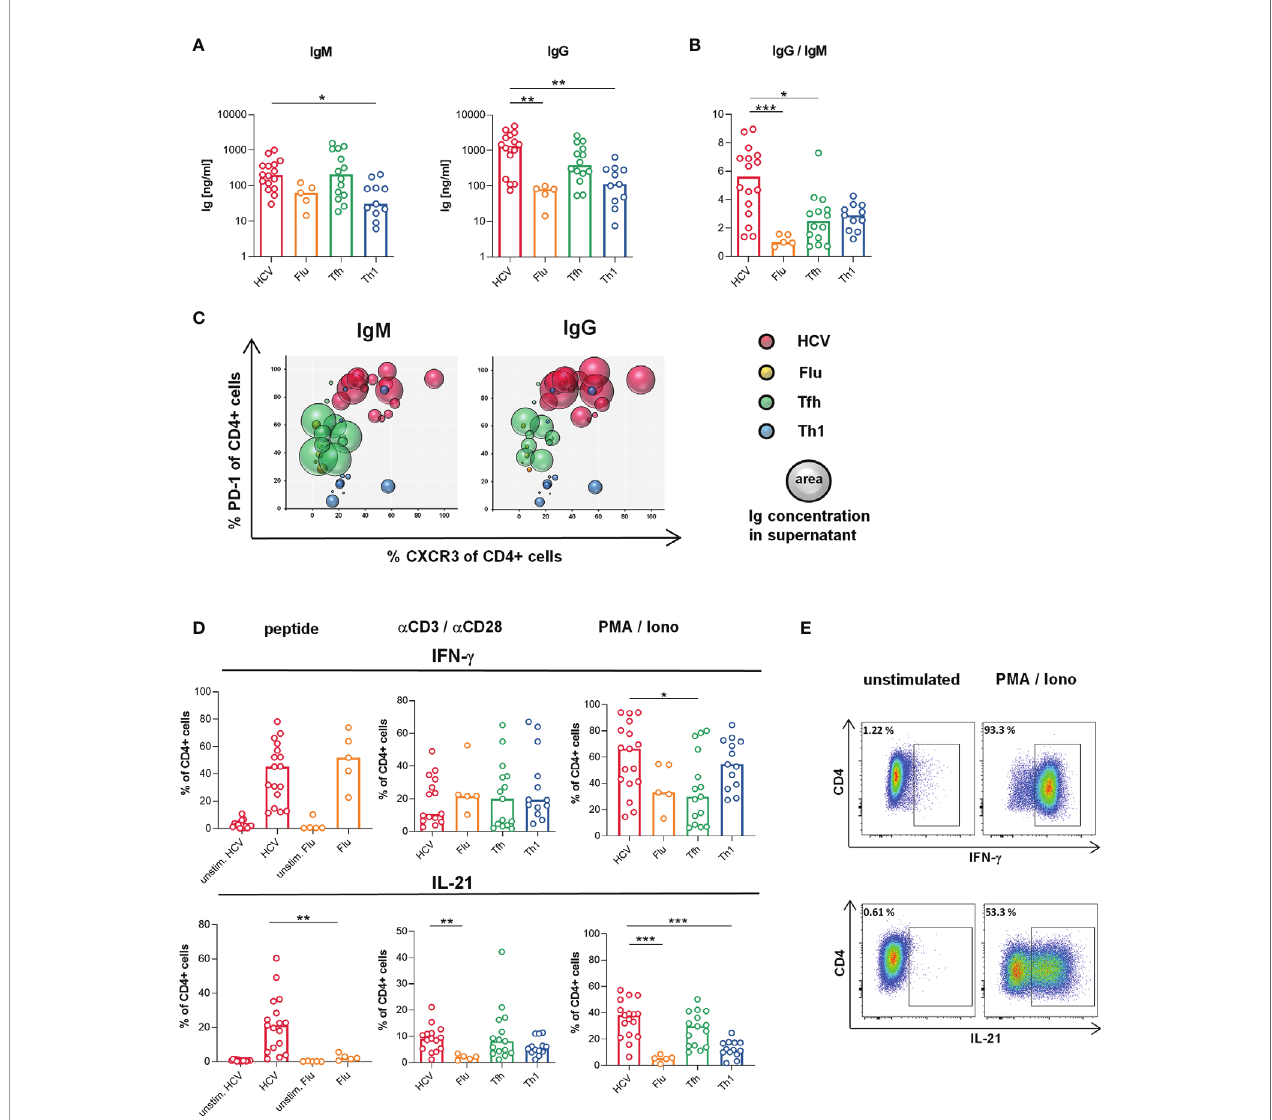
FIGURE 2 | Superior B cell helper capacity despite Th1-biased cytokine production of HCV clones. (A, B) B cell helper capacity was analyzed by coculture of the CD4 T cell clones (n = 16 HCV, 5 Flu, 14 Tfh, 11 Th1 clones) with naive allogeneic B cells for 7 d (A) Concentrations of IgM and IgG in cell-free coculture supernatants were determined by ELISA. (B) Class switch induced by the CD4 T cell clone types as ratio of IgG and IgM concentration in culture supernatants. For coculture system validation plasmablast formation was correlated with produced Ig (Supplementary Figure 7A) . B cell positive and negative controls and autologous in-run controls are shown in Supplementary Figures 7C, D , respectively. (C) The correlation of CXCR3 and PD-1 surface expression (shown in Figures 1D ) with the individual B cell helper capacity is visualized in bubble plots (n = 16 HCV, 5 Flu, 11 Tfh, 11 Th1 clones). (D) Production of IFN- g and IL-21 by the CD4 T cell clone types was determined by fl ow cytometry after stimulation with their respective peptide (n = 17 HCV, 15 unstim. HCV, 5 Flu, 5 unstim. Flu clones), a CD3/ a CD28 (n = 15 HCV, 5 Flu, 15 Tfh, 13 Th1 clones) or PMA/Iono (n = 17 HCV, 5 Flu, 15 Tfh, 13 Th1 clones). (E) Representative pseudocolor plots of cytokine stainings after PMA/Iono stimulation. (A, B, D) Bars indicate the median. Each symbol represents one CD4 T cell clone of the indicated type. Kruskal-Wallis test with Dunn ’ s test for multiple comparisons was applied to compare differences between all groups to HCV clones as control. Mann-Whitney rank sum test was used to compare two groups. *p < 0.05; **p < 0.01; ***p <